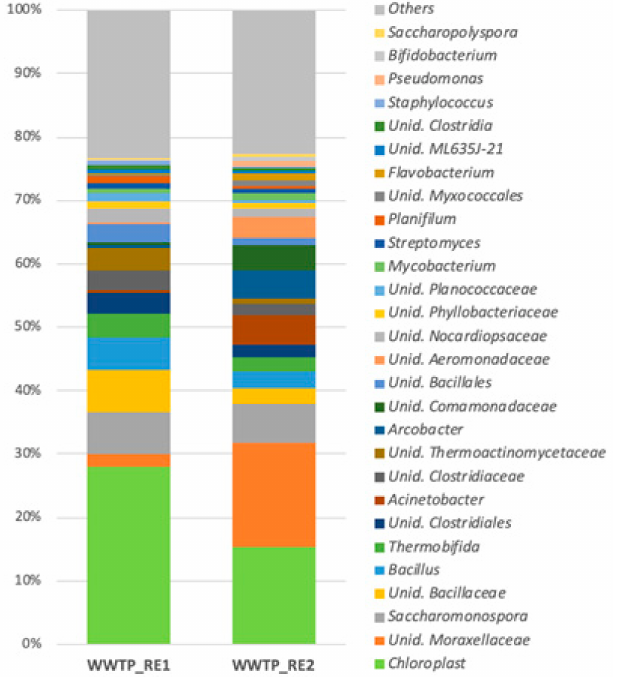
Figure 6. Most abundant genera ( > 1%) in WWTP_RE1 and WWTP_RE2 samples (Unid, unidentified). Chloroplast (27.9% and 15.4%, respectively), Moraxellaceae (2% and 16%, respectively), Bacillus (5.1% and 2.5%, respectively), and Bacillaceae (6.7% and 2.5%, respectively) were the main existing